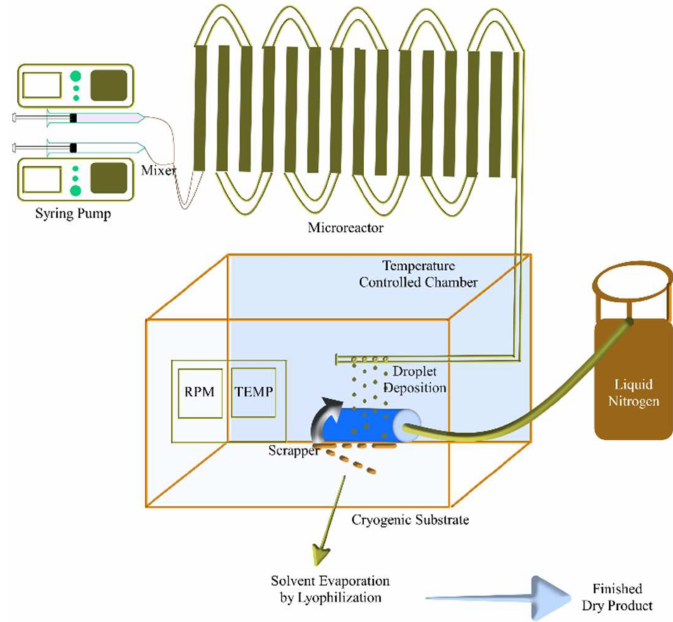
Figure 1. Model setup of the TFF system. Table 1. Summary of enabling technologies to produce DPI